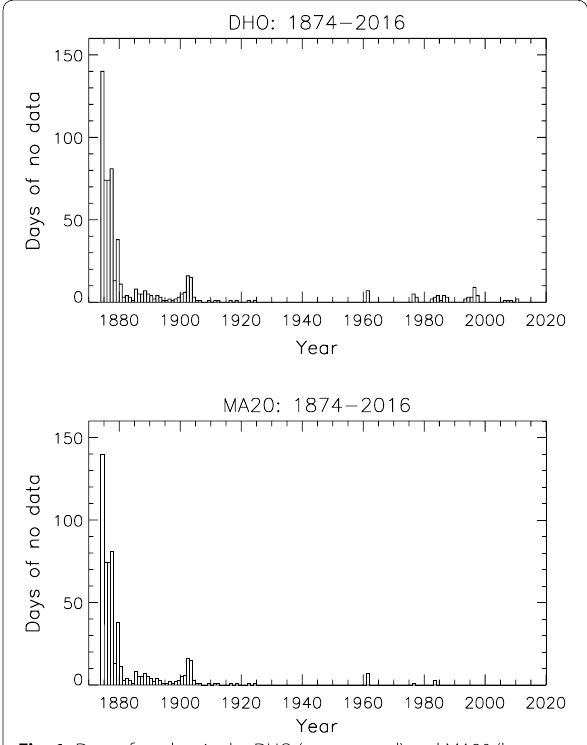
Fig. 1 Days of no data in the DHO (upper panel) and MA20 (lower panel)